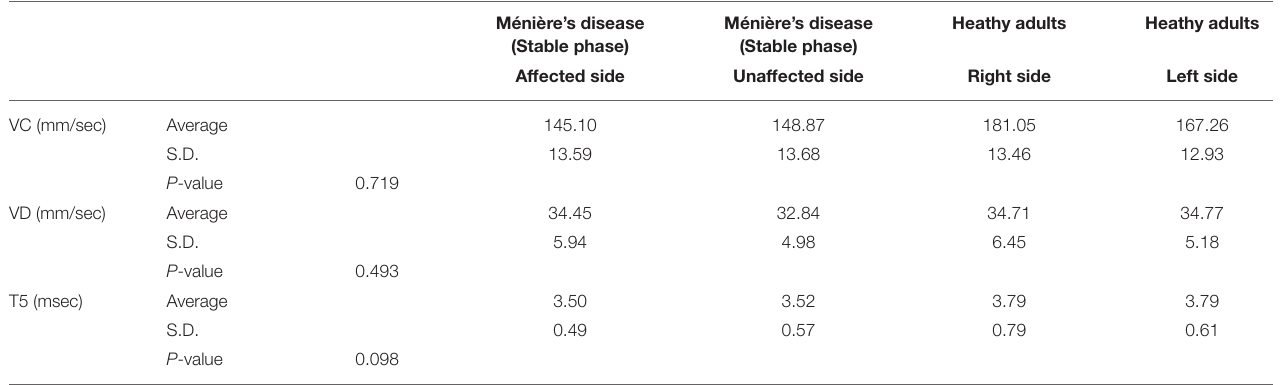
TABLE 2 | Electronic pupillometry analysis in 31 patients in a stable phase of Ménière’s disease and 31 age-matched healthy